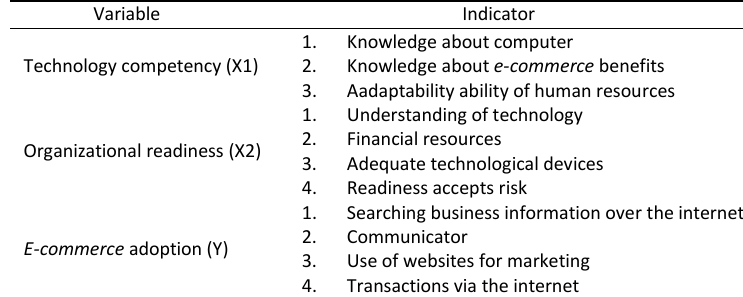
Table 1: Research variables and indicators